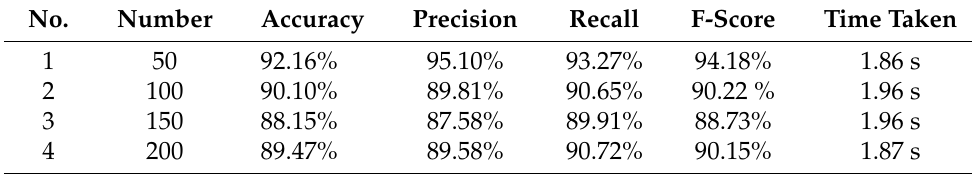
Table 6. Command type d Experimental results.